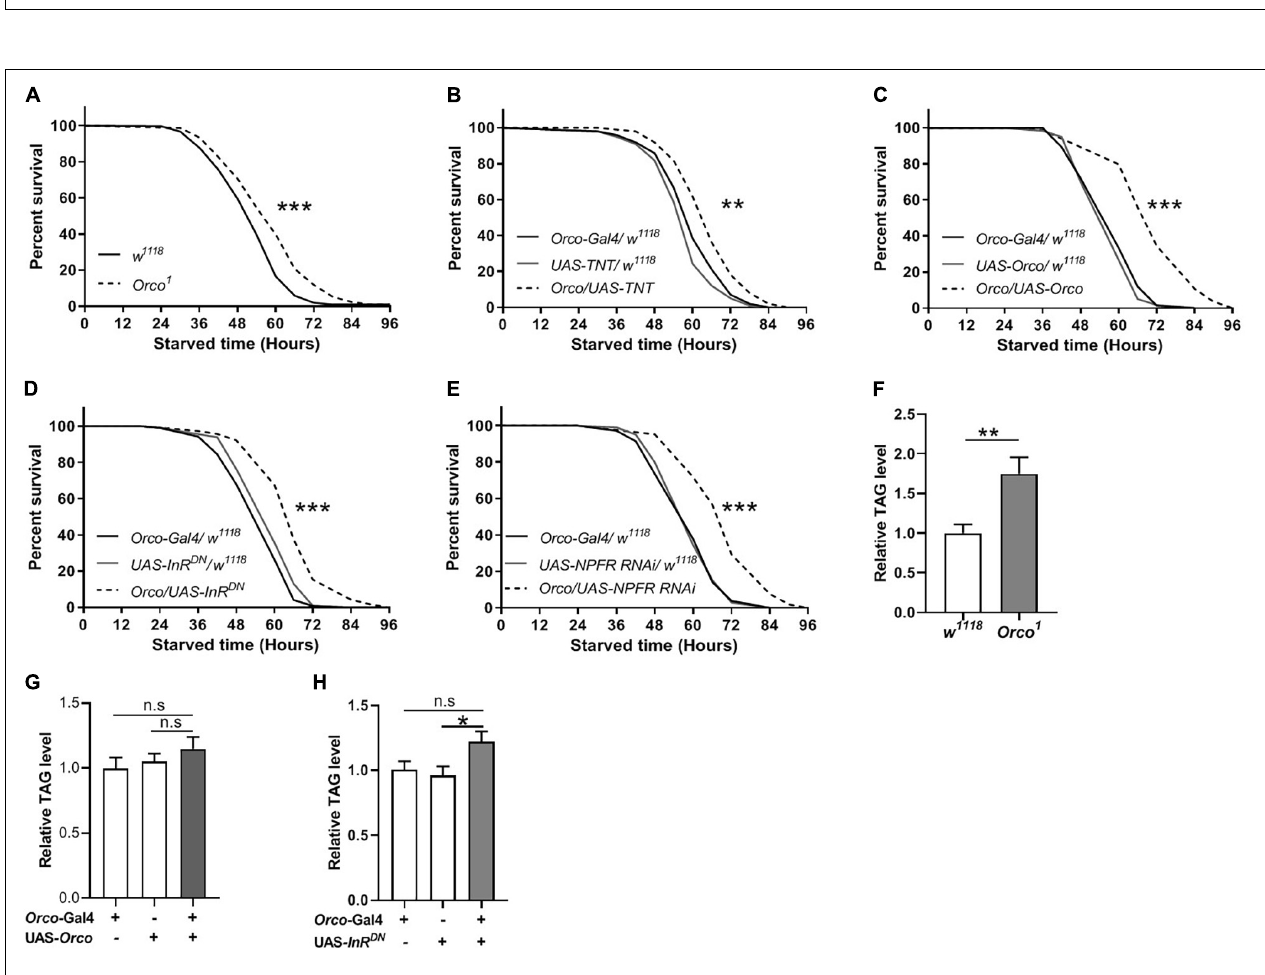
FIGURE 6 | OSNs regulate starvation resistance and lipid metabolism. (A) Orco 1 mutant flies had longer survival lifespan under starved condition than w 1118 flies ( n = 9 vials/group). (B) Blocking OSNs by expressing TNT enhanced the starvation resistance ( n = 9 vials/group). The resistance to starvation was increased after expressing Orco in OSNs (C) ( n = 11–12). Decreasing InR activity (D) or decreasing NPFR level (E) in OSNs extended the survival lifespan under starved condition ( n = 10). (F) Orco 1 mutant flies had higher triacylglycerol (TAG) level than w 1118 flies ( n = 9). The level of TAG did not affect after expressing Orco (G) and decreasing InR activity (H) ( n = 9–10). * p < 0.05, ** p < 0.01, and *** p < 0.001.